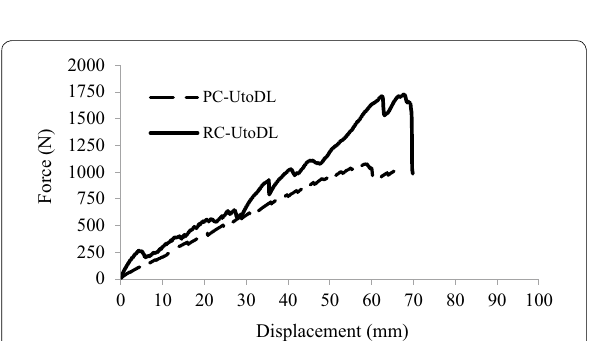
Fig. 9 Illustration of failure locations of rehabilitated chair layouts ( a – c ); and their typical corresponding failure ( d ) due to the fracture at a joint, e owing to the loosening of springs, and f due to the failure of wood in withstanding the tensile strength at the curved region